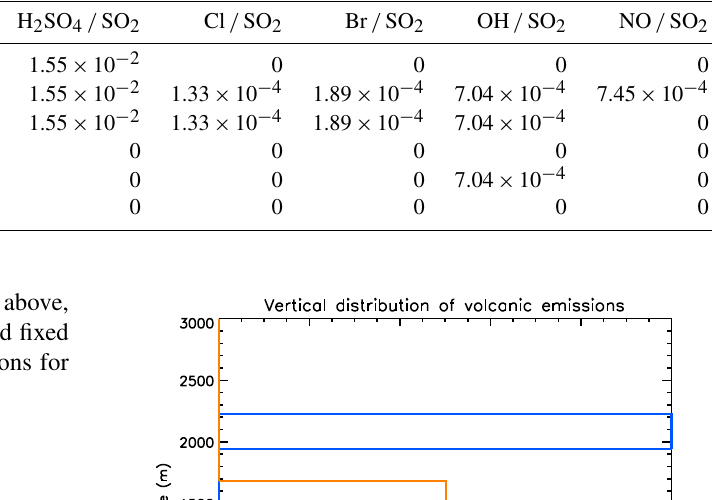
Table 4. Emissions of HCl, HBr, sulfate and radicals (Cl, Br, OH, NO) expressed in terms of mass ratios relative to SO 2 emissions for all the volcanoes within the domain study and for the different simulations (see Sect. 2.3.3 for the details on the ratio derivation and Sect. 2.3.4 for details on the simulations). Note that for S1_no_hal, S1_no_hal2 and S0 simulations, the ratios indicated here are only for the emissions of Ambrym Volcano. These simulations have the same emissions as S1_HighT for the other volcanoes within the domain study. Note also that all the simulations, except S0, have an SO 2 emission for Ambrym of 18.8ktday − 1 . S0 does not include any volcanic emissions from Ambrym.